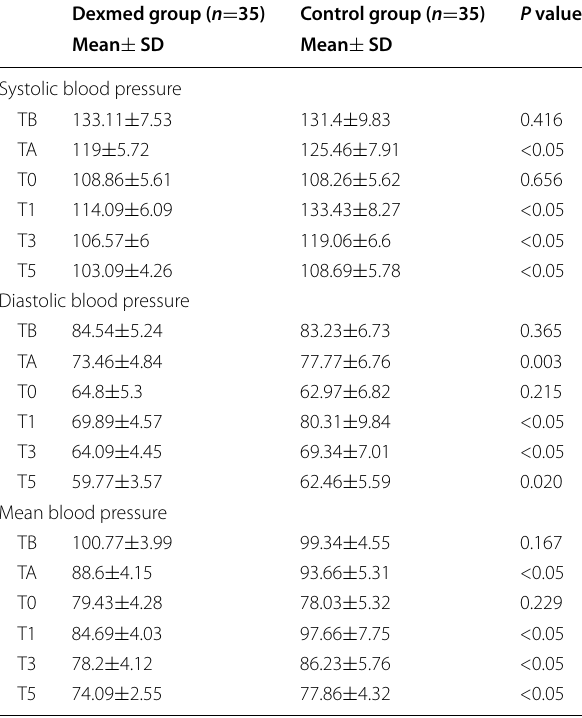
that dexmedetomidine attenuated the sympathoadrenal response to intubation that resulted in the attenuation of heart rate with a dose of 0.6 mcg/kg (Jaakola et al. 1992). Pre-induction dexmedetomidine attenuated the hemo- dynamic responses to intubation, reduced the required Table 3 Changes in blood pressure in both studied